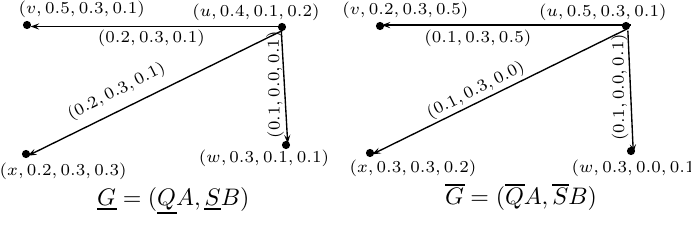
Figure 9. Neutrosophic soft rough graph G “ p G , G Figure 9: Neutrosophic soft rough graph G = ( G, G )